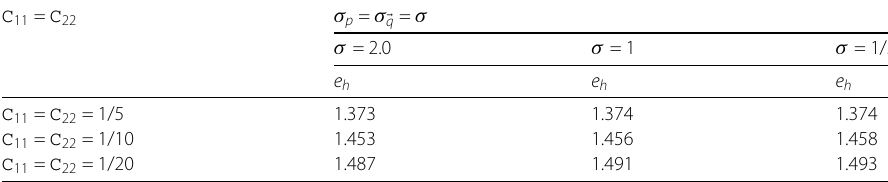
√ √ 2,1/ 2) and speed c = 1/2